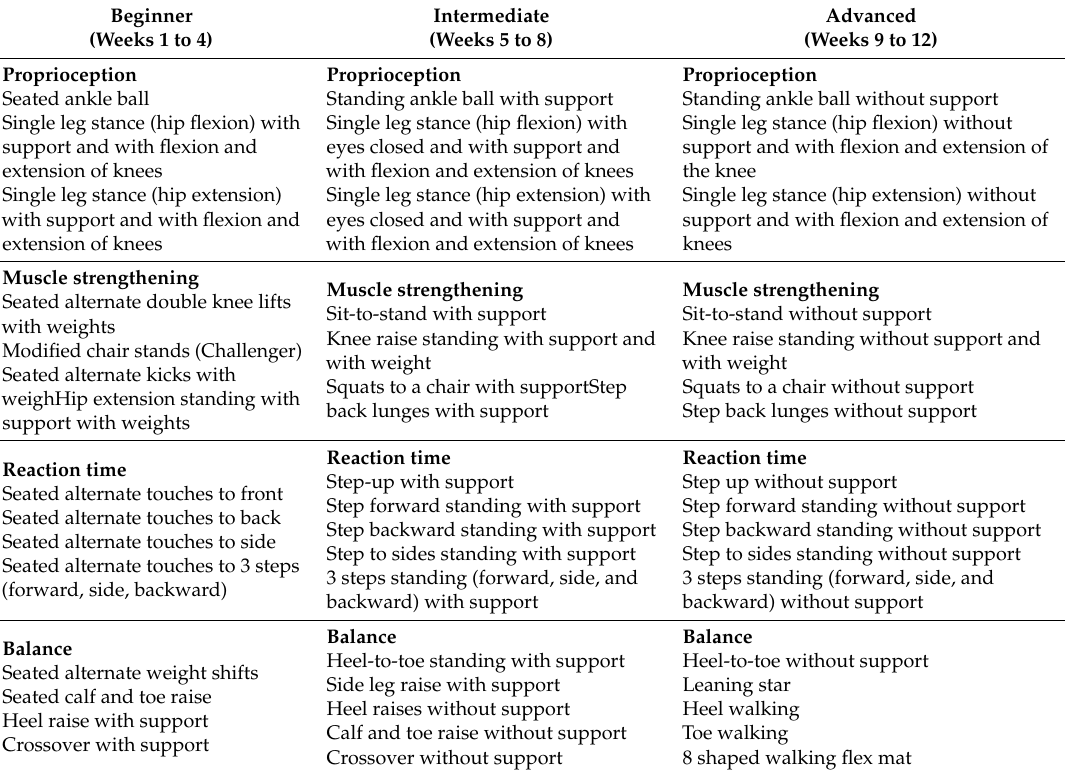
Table 1. Multi-system Physical Exercise (MPE) training